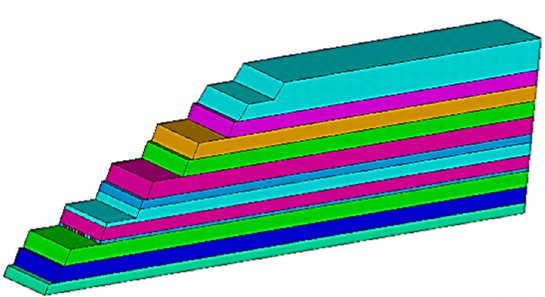
Fig. 19 Meshing after highwall mining